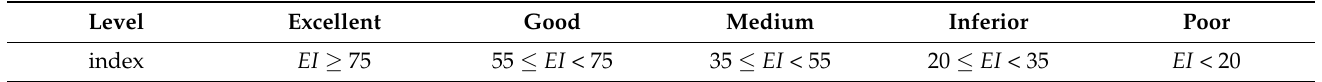
Table 3. Ecological environmental status classification.